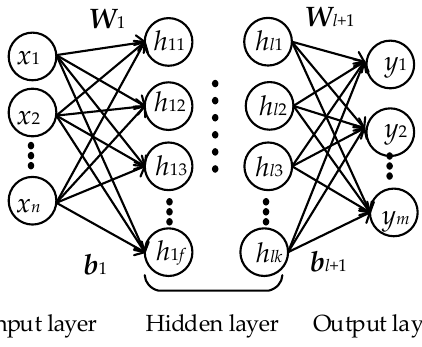
Figure 3. The fully connected deep neural network structure.